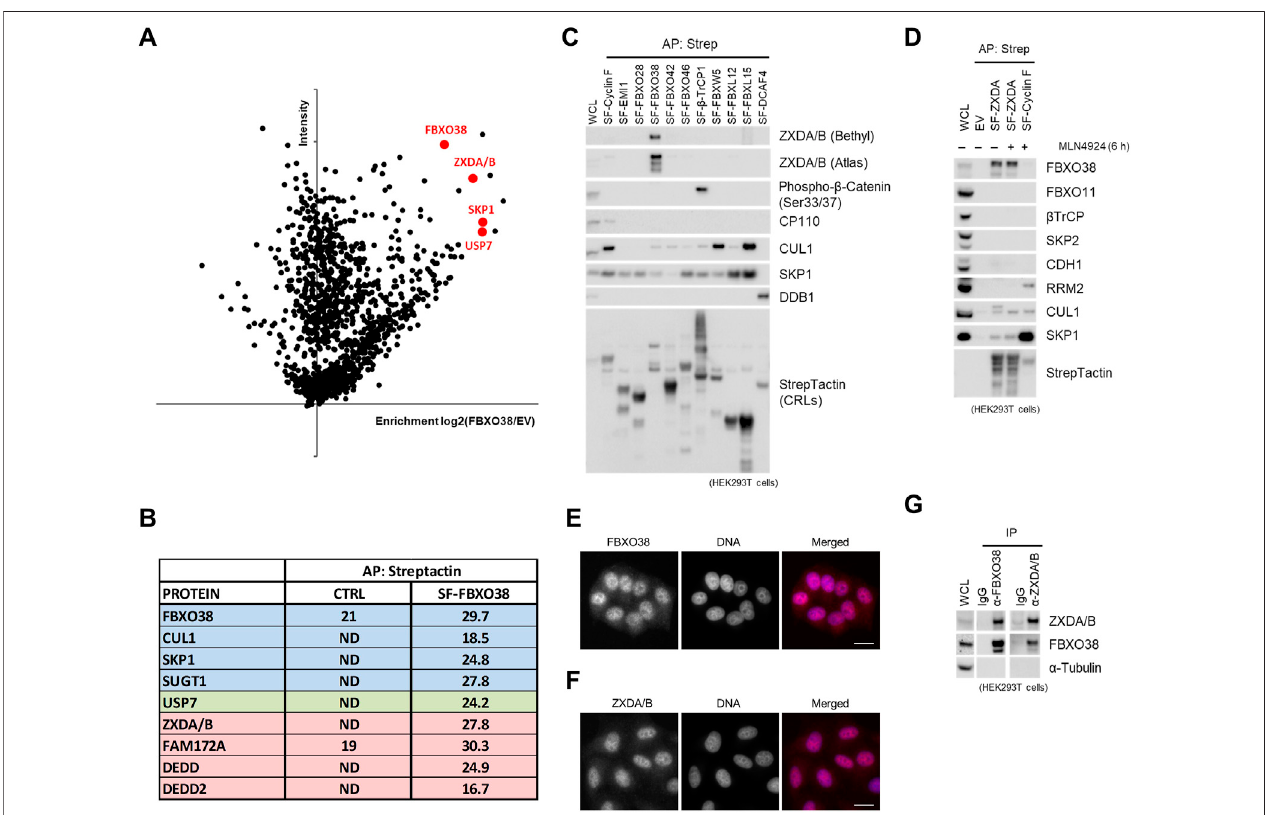
FIGURE 1 | FBXO38 interacts with ZXDA/B in the nucleus. (A) Schematic representation of mass-spectrometry identi fi cation of FBXO38-interacting proteins. Af fi nity-puri fi ed proteins from HeLa cells expressing StrepII-FLAG-tagged FBXO38 (SF-FBXO38) were identi fi ed by Liquid Chromatography with Tandem Mass- Spectrometry (LC-MS/MS). Parental HeLa cells without FBXO38 expression were used as a negative control. Proteins that were signi fi cantly enriched in FBXO38 puri fi cations compared to the control are in red. The graph represents maximum intensity and the enrichment calculated from the ratio of intensities of identi fi ed proteins. (B) The list of speci fi c hits enriched in FBXO38 puri fi cations identi fi ed by the LC-MS/MS analysis as in (A) . Log 2 intensities from FBXO38 puri fi cations or the control are shown. Components of SCF FBXO38 are depicted in blue, putative substrates in red, and other associated proteins in green. (C) HEK293T cells were transfectedwithSF-taggedCullin-RINGligasesubstratereceptors(CRLs).CellsweretreatedwiththeMLN4924inhibitor6 hpriortocollecting.Whole-celllysates(WCL) wereaf fi nitypuri fi ed(AP)usingStrep-Tactinresinandimmunoblottedasindicated.Aspositivecontrols,phospho- β -cateninisshowntointeractwith β -TrCP,andCP110 is shown to interact with Cyclin (F) . Two anti-ZXDA/B antibodies were used to ensure interaction speci fi city. (D) HEK293T cells were transfected with SF-ZXDA or SF- CyclinFandsubjectedtolysisandAPasin (C) .Anemptyvector(EV)wasusedasanegativecontrol.Whereindicated,theMLN4924inhibitorwasaddedtothecells6 h priortocollecting.RRM2isshowntointeractwithCyclinFasapositivecontrol. (E) FBXO38localizestothenucleus.HeLacellswere fi xed,permeabilized,andincubated withananti-FBXO38antibody.DNAwasstainedwithDAPI.Scalebar,20 µm (F) ZXDA/Blocalizestothenucleus.HeLacellsweretreatedasin (F) andincubatedwithan anti-ZXDA/Bantibody.DNAwasstainedwithDAPI.Scalebar,20 µm. (G) EndogenousFBXO38orendogenousZXDA/BwereimmunoprecipitatedfromHEK293Tcells using either FBXO38 or a ZXDA/B antibody. Non-speci fi c IgG was used as a negative control. Whole-cell lysates (WCL) and immunoprecipitations (IP) were immunoblotted as